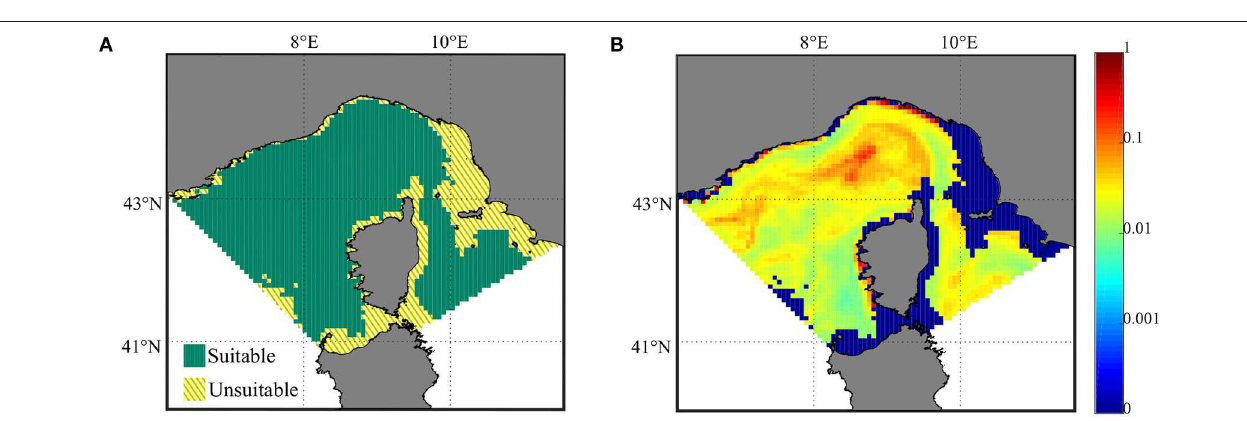
FIGURE 5 | Maps of exposure to plastic and of the related risk for the fin whale. (A) Boolean mask representing the average suitable habitat in 2002–2010 , calibrated using a simplification of the model by Druon et al. (2012). (B) Average risk of plastic ingestion by B. physalus in 2002–2010, as resulting from multiplying the hazard and the exposure monthly